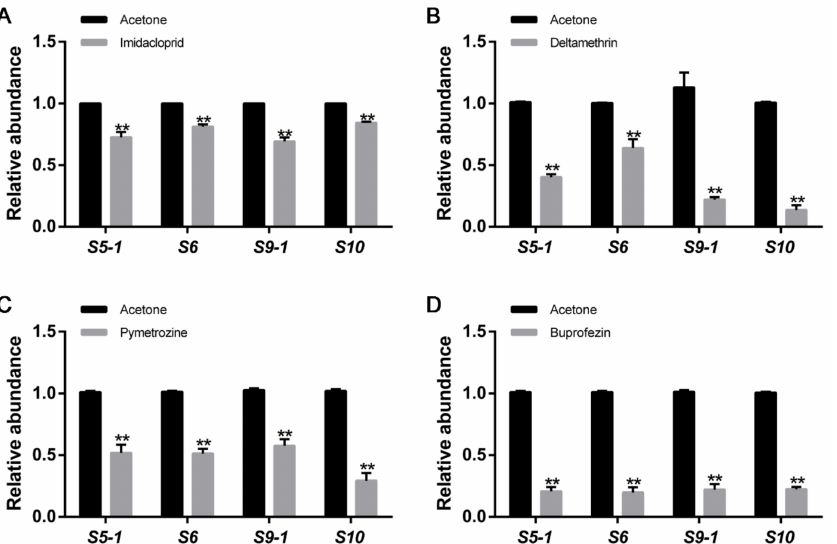
Figure 1. The effects of insecticides on RBSDV infection in L. striatellus . ( A – D ) The relative expression of RBSDV replication related genes, S5-1 , S6, and S9-1, and coat protein gene, S10 , were significantly decreased in L. striatellus after injection of imidacloprid, deltamethrin, pymetrozine, and buprofezin by microinjection, respectively. The asterisks (**) indicate p <